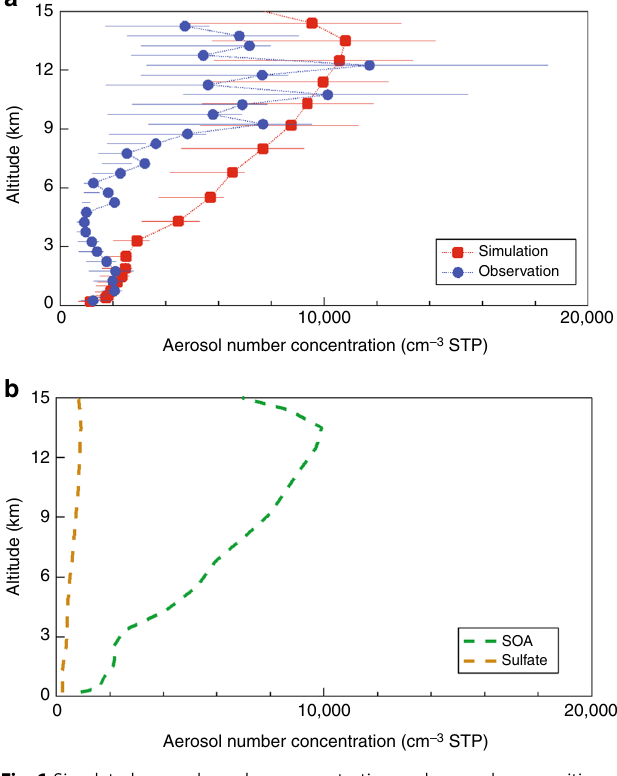
Fig. 1 Simulated aerosol number concentration and aerosol composition over the Amazon. a Comparison of the simulated multi-year average September and October mean total aerosol number concentration over the Amazon and the observed vertical pro fi le from ref. 26 . Both the model results and observations are those with diameters above 10 nm in the lower troposphere and 20 nm in the upper troposphere. The error bar indicates the 25th and 75th percentile of aerosol number concentration for each height layer. b The number concentration of newly nucleated sulfuric acid and secondary organic aerosol (newSOA)